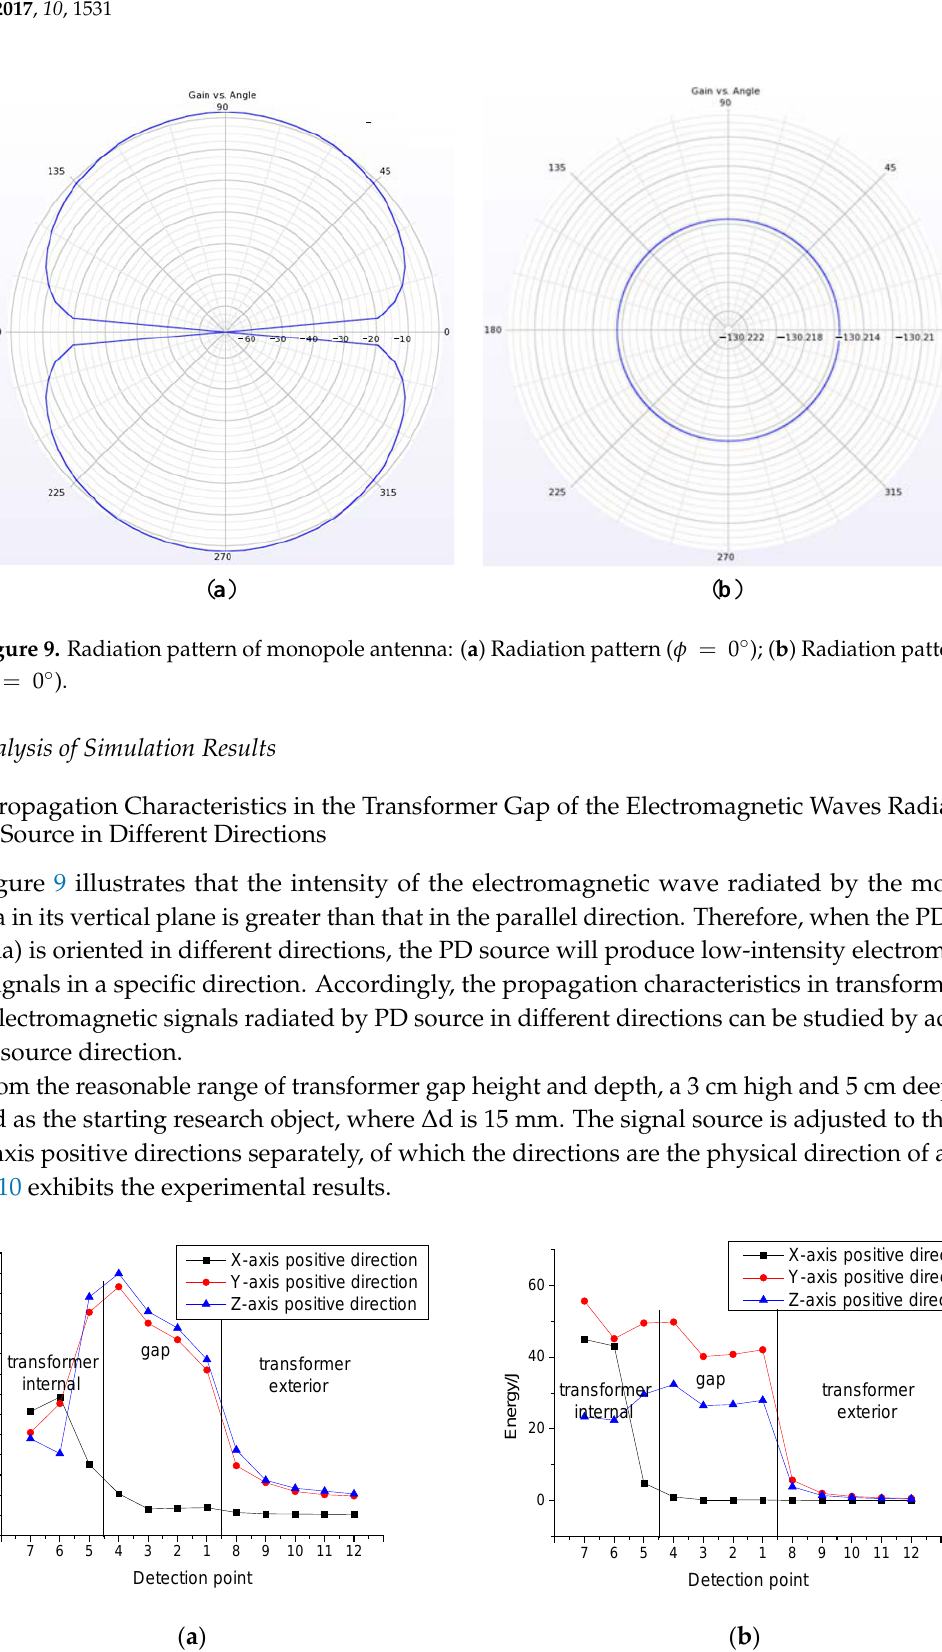
Figure 10. Distributions of electromagnetic signals radiated by PD source in different directions: ( a ) Amplitude distribution; ( b ) Energy distribution.